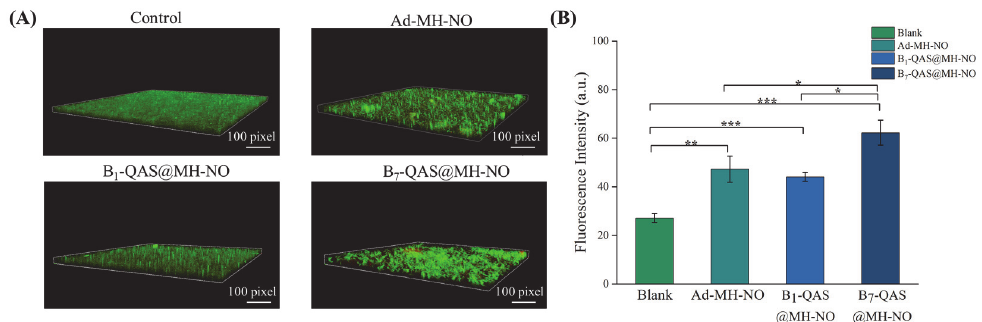
Figure 8. ( A ) Confocal laser scanning microscopy (CLSM) observation of E. coli films after incubation with PBS, Ad-MH-NO, B 1 -QAS@MH-NO, and B 7 -QAS@MH-NO. ( B ) The quantitative analysis of fluorescence intensity. * p < 0.05, ** p < 0.01, *** p < 0.001.